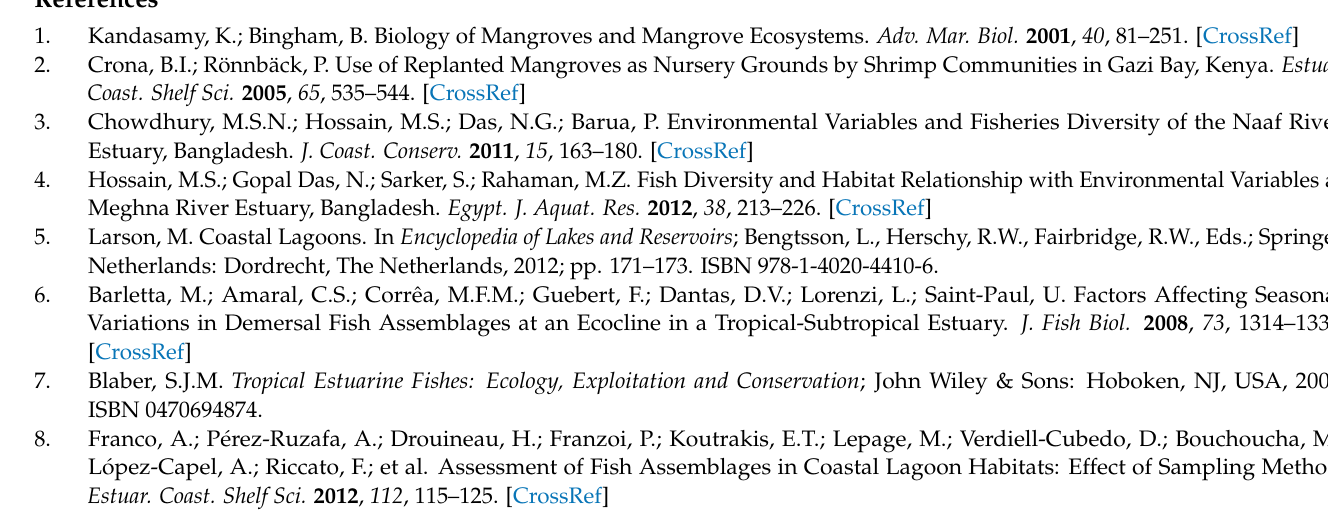
Table S5. PERMANOVA results of the pairwise comparisons between the factor “zones” for the matrix of fish assemblages using Bray-Curtis similarity for the resemblance